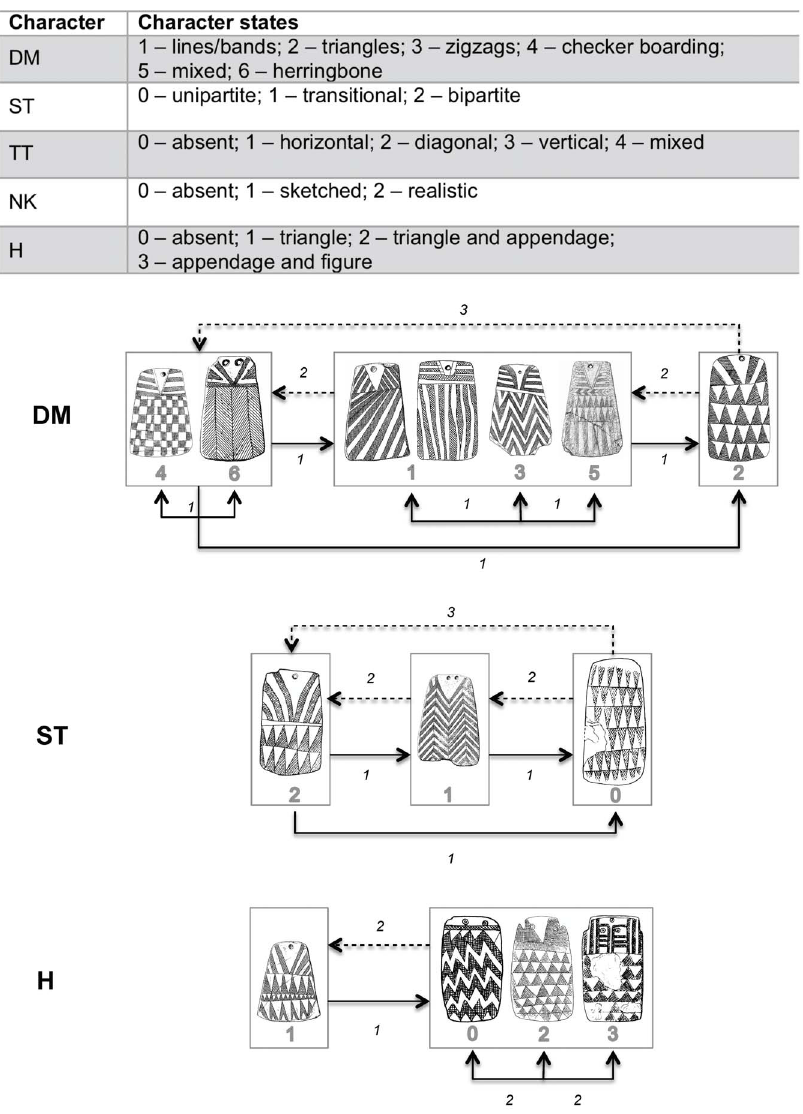
Figure 5. Characters and character states used in the analysis reported here, together with polarities and cost of transitions between states for characters DM, ST, and H, with polarity set by Lillios’s hypothesis. Plaques appearing within one rectangle have the same polarity. Continuous lines indicate less-costly transitions, and dashed lines indicate more-costly transitions. Numbers indicate cost values for corresponding transitions in exercises 3 and 4 (Table 5).